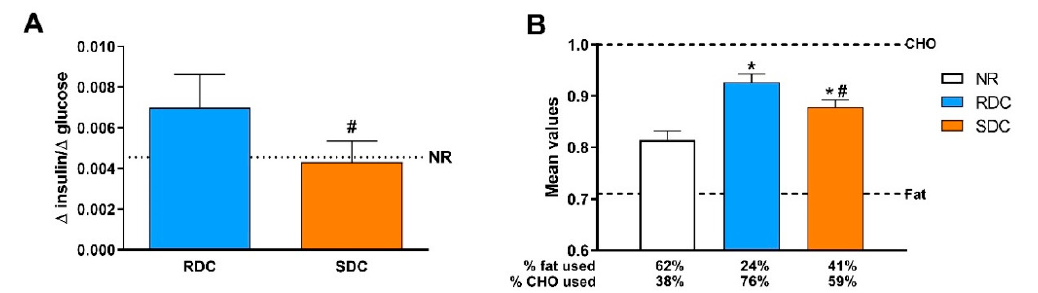
Figure 2. Insulin sensitivity and Energy substrate utilization in the experimental groups. ( A ). Insulin to glucose ratio. ( B ). Indirect calorimetry in the Catch ‐ up growth experimental model. The basal respiratory quotient is shown. NR group, not restricted; RDC group, re ‐ feeding with rapid digestible CHO diet; SDC group, re ‐ feeding with slow digestible CHO diet. * Significant difference with NR group, p < 0.05. # Significant difference with RDC group, p < 0.05.